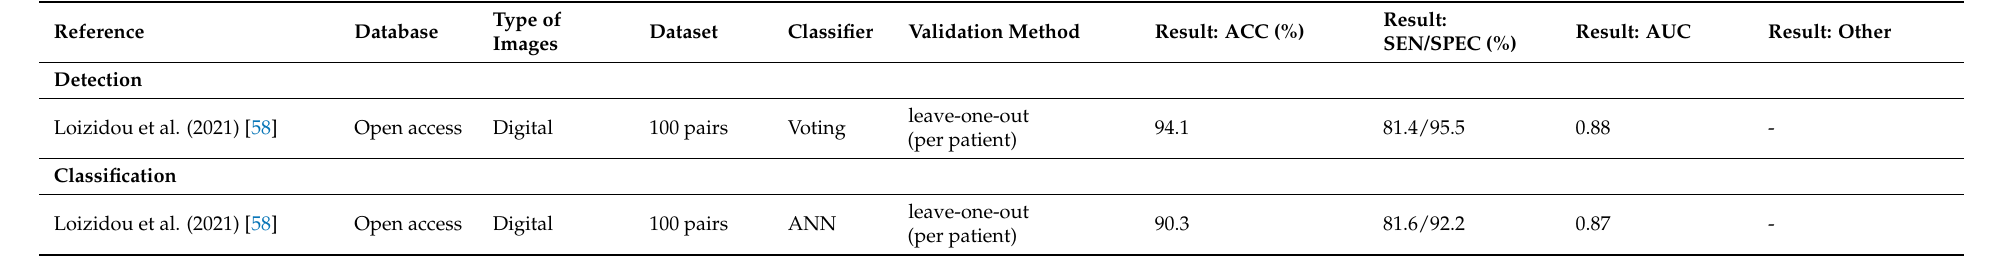
Table 6. Comparison of algorithms for the diagnosis of MCs in sequential mammograms using temporal subtraction and feature-based machine learning.